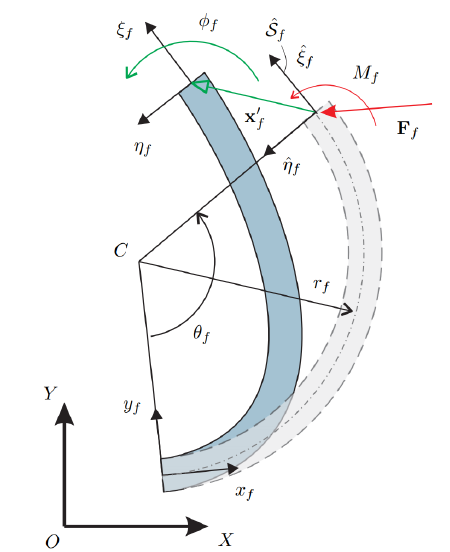
Figure 1. Curved beam in its initial (dashed line) and deformed configuration (solid